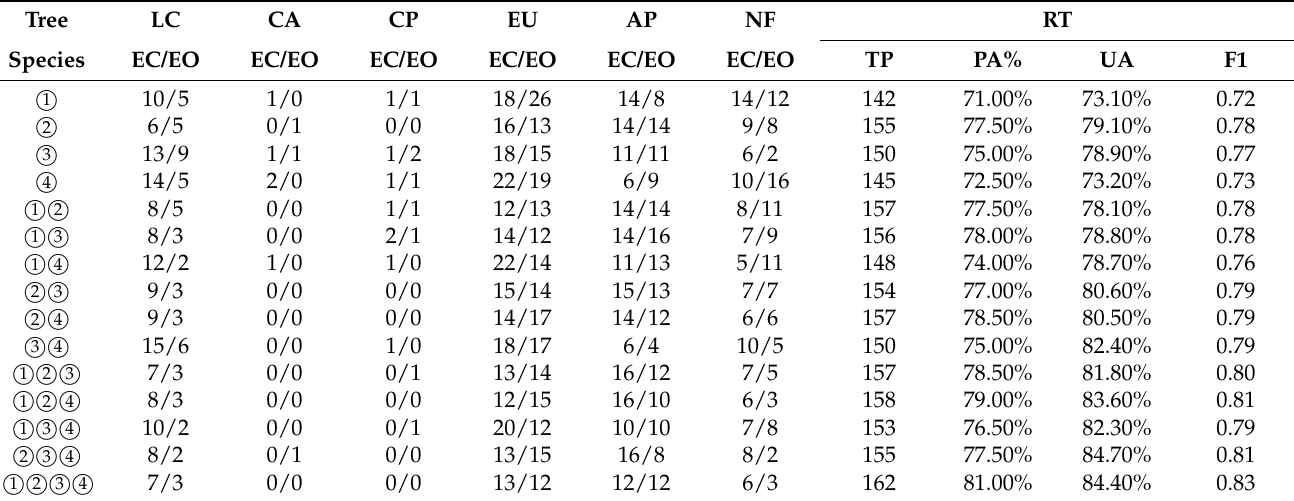
Table 3. Accuracy assessment of rubber plantation mapping